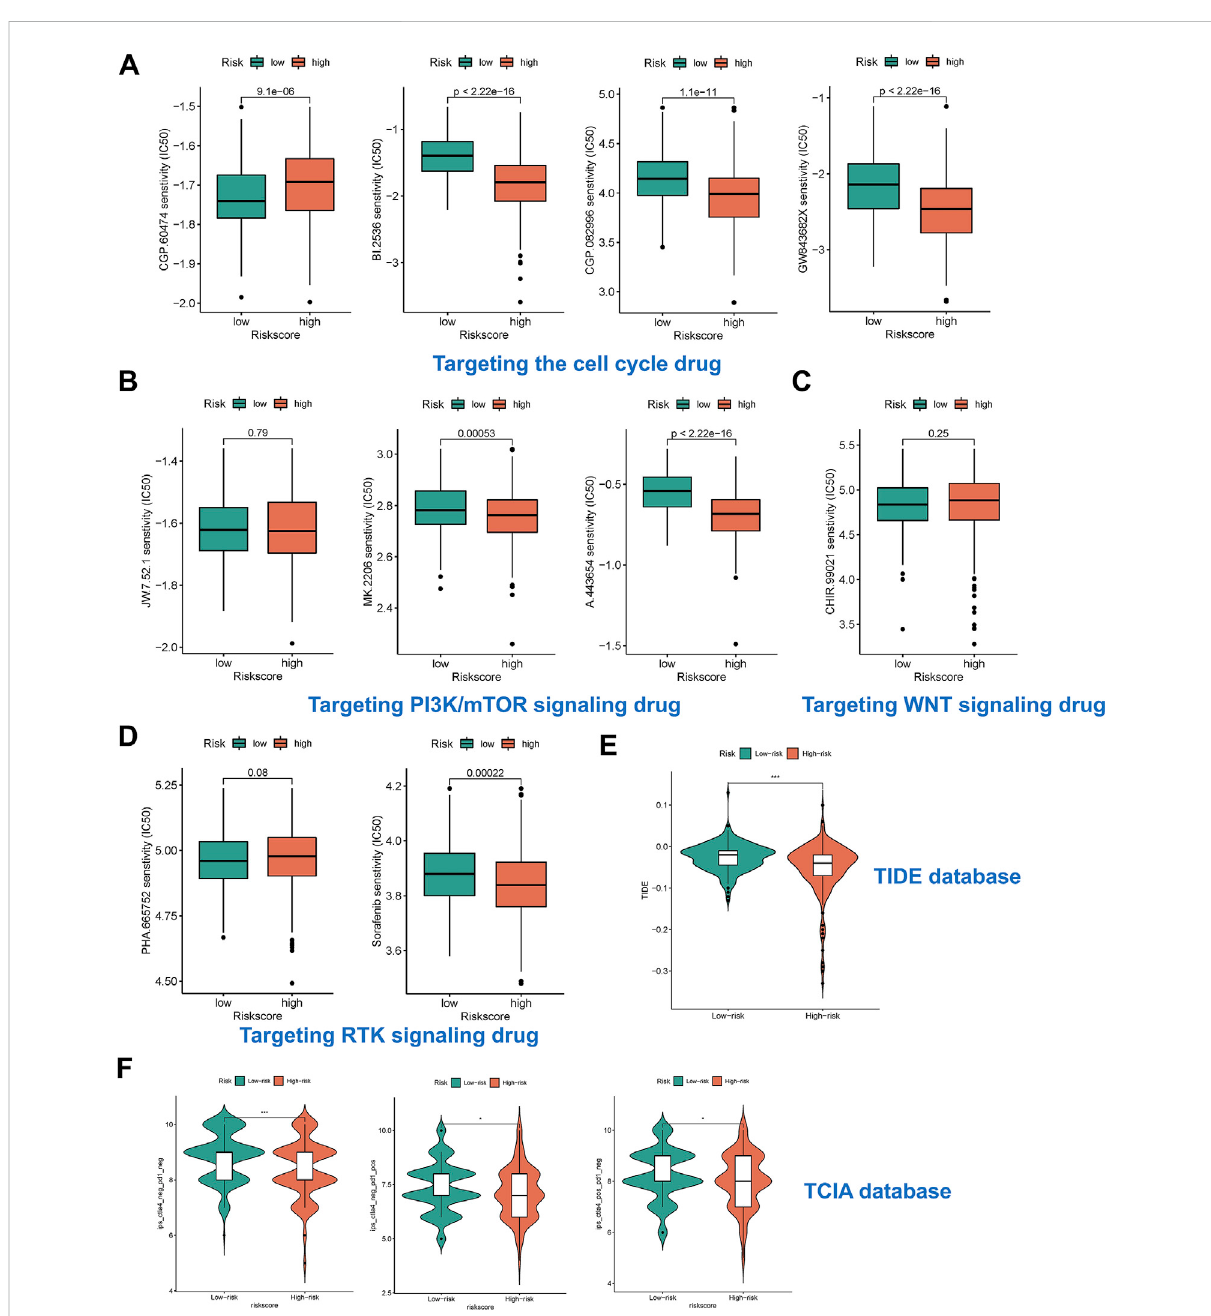
FIGURE 7 Risk subtypes could re fl ect drug resistance. (A) The box plot of targeting cell cycle drug in different risk groups, including CGP-60474, GW843682x, BI-2536, and CGP-082996. (B) The box plot of targeting PI3K/mTOR signaling drug in different risk groups, including JW-7-52-1, MK- 2206, and A-443654. (C) The box plot of targeting WNT signaling drug in different risk groups, including CHIR-99021. (D) The box plot of targeting RTK signaling drug in different risk groups, including Sunitinib and PHA-665752. (E) The box plot of TIDE score in different risk groups. (F) The box plot of IPS in different risk